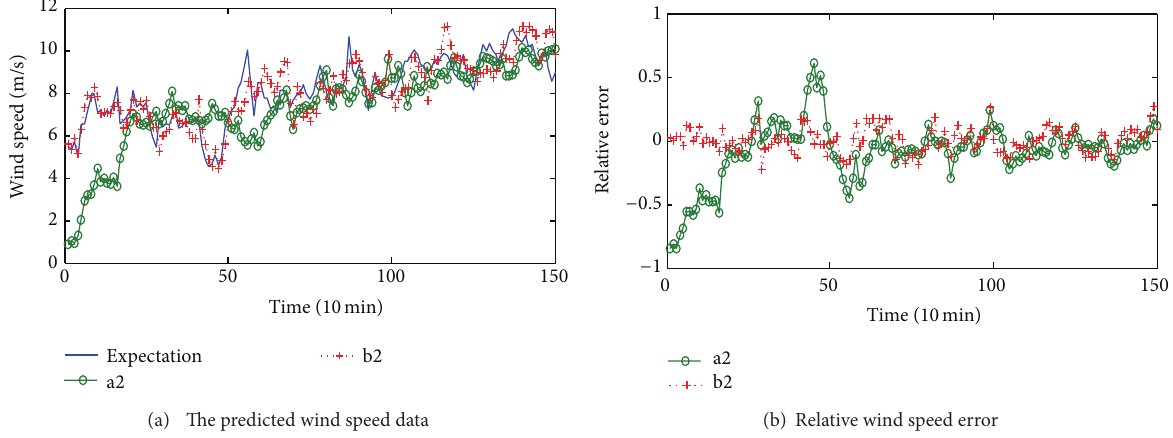
Figure 2: The effect comparison between a2 and b2.